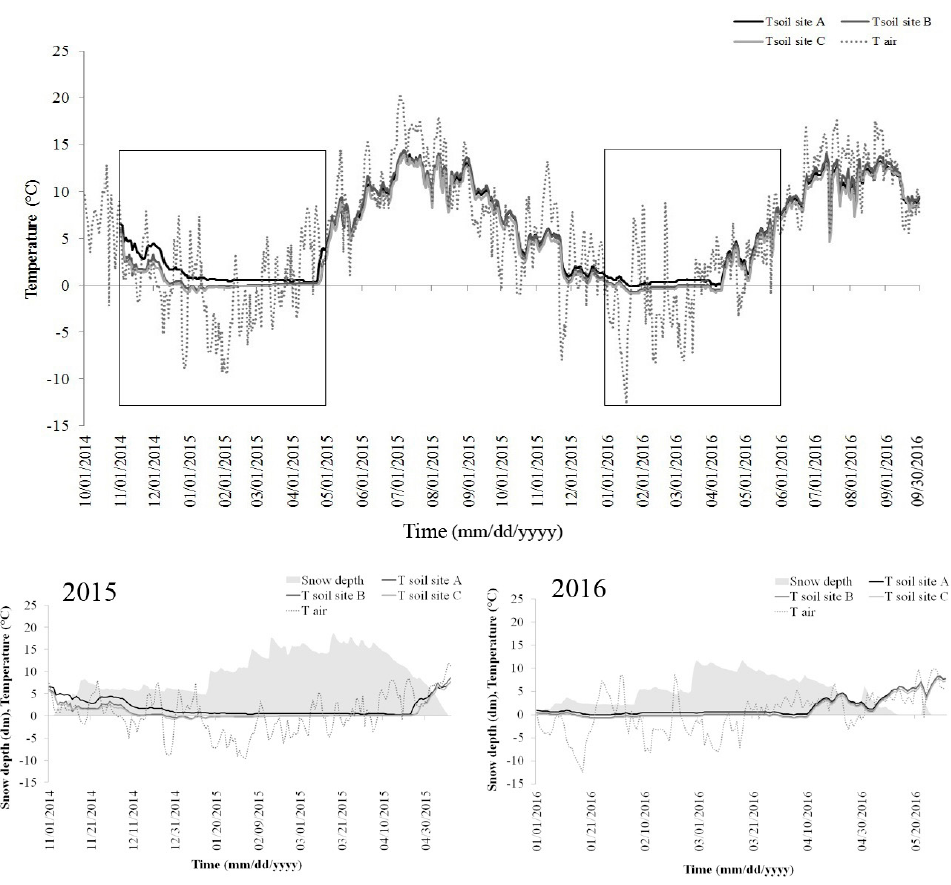
Figure 3. Daily mean air temperature (from AMS) and soil temperature (T soil, °C) in the 3 study sites along the experimental period (from October 1, 2014, to September 30, 2016) and focus on snow depth (dm), air temperature (T air, °C), and soil temperatures when snow cover was detected by AMS. Table 3. Snow cover duration (SCD), number of freeze/thaw cycles (FTCs), intensity of soil freezing (ISF), cumulative days of soil freezing (DSF), and period of soil freezing (Date of SF) in each study site measured over the two years.